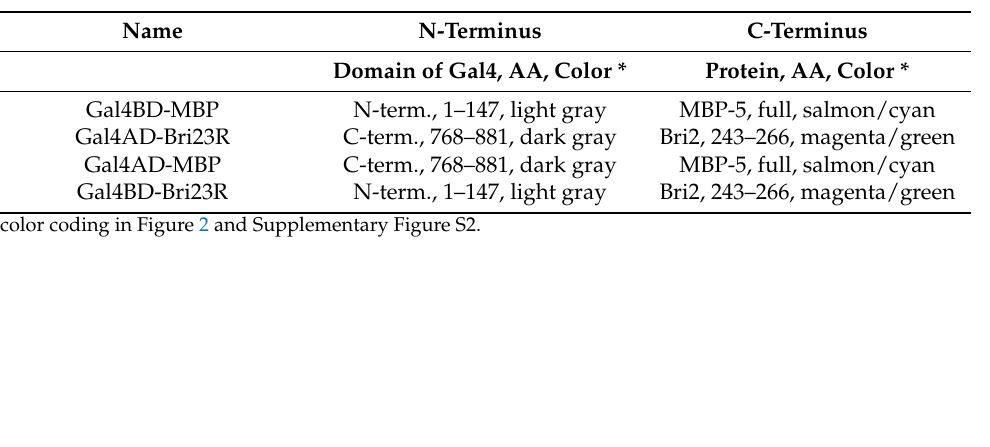
Table 1. The description of the fusion proteins, which were used in the computational study.